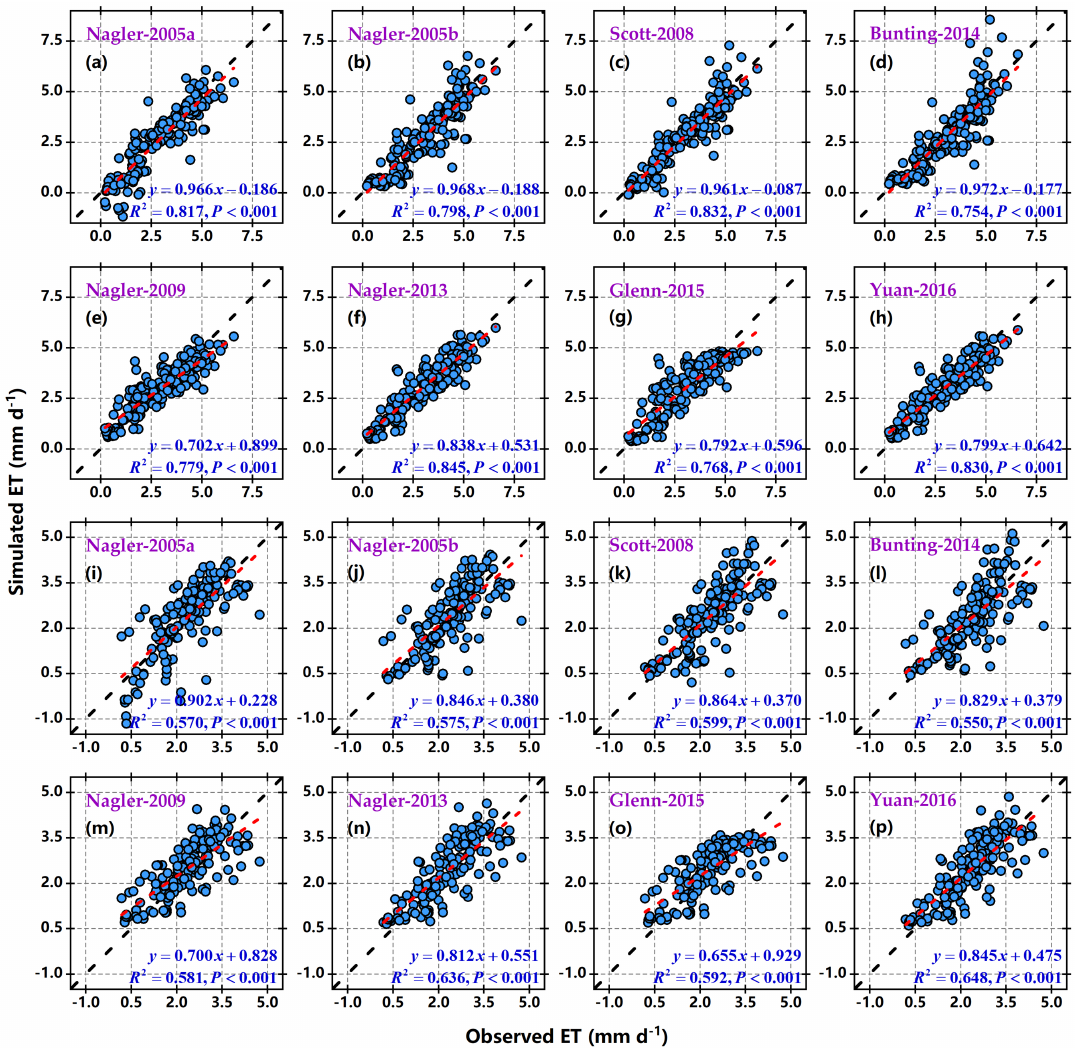
Figure 5. Scatter plots of the observed and simulated ET for each day throughout the 2017 growing season of the Tamarix site ( a – h ) and each day throughout the 2016 growing season of the Populus site ( i – p ). The red and black dashed lines are the regression lines and the 1:1 lines,